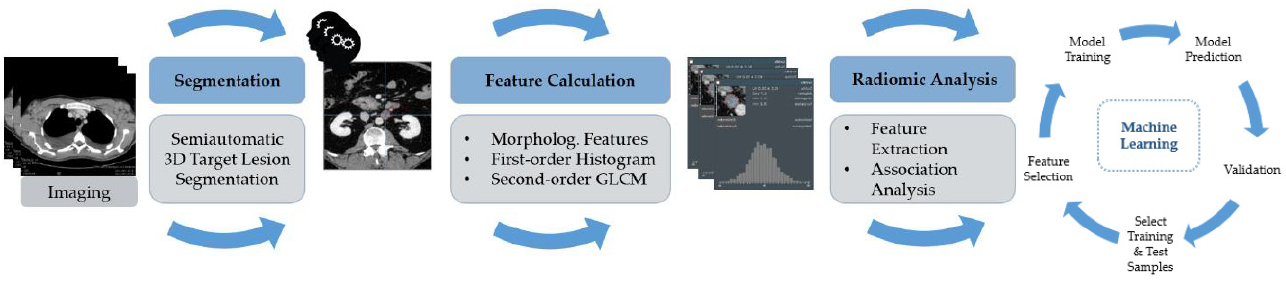
Figure 2. The schematic diagram for processing and analysis in the machine learning approach. Morphological features, including volume and textural features of first and second-order, were obtained. Details regarding the extraction settings are listed in Appendix A, Table A1.